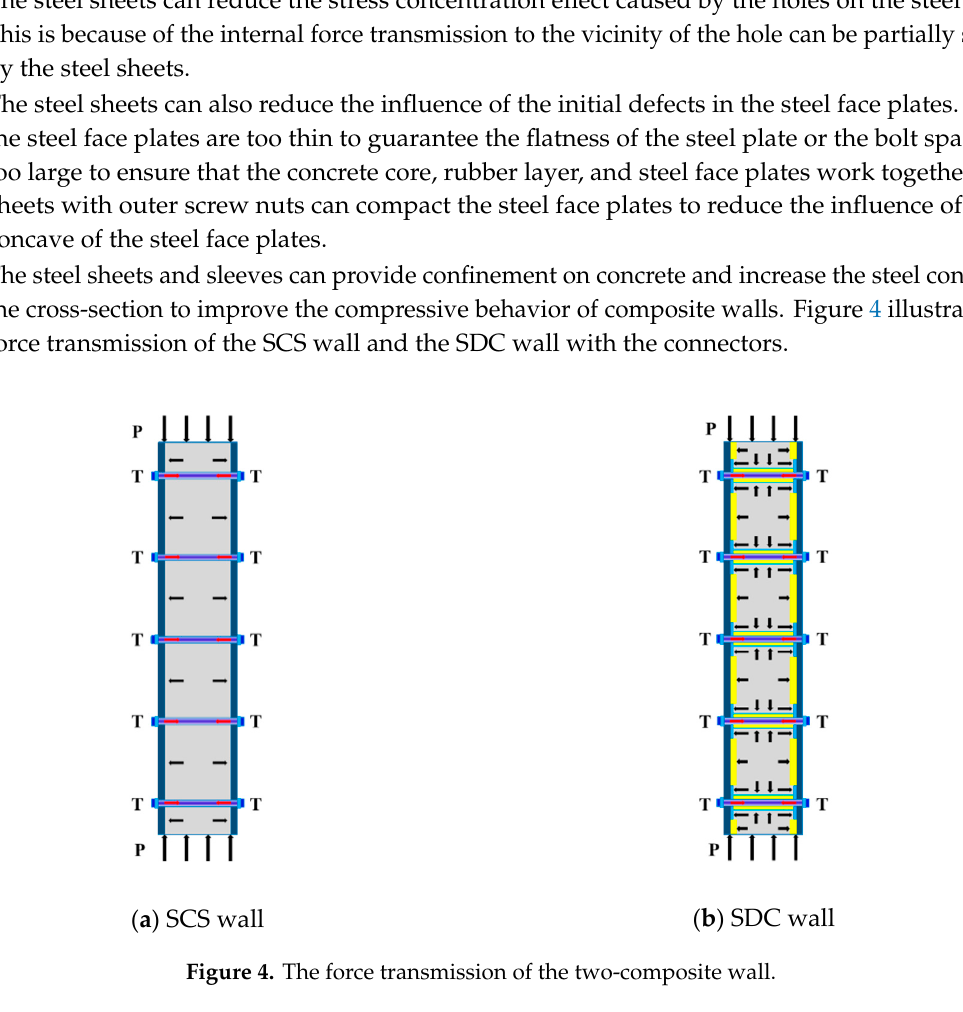
Figure 4. The force transmission of the two-composite wall.